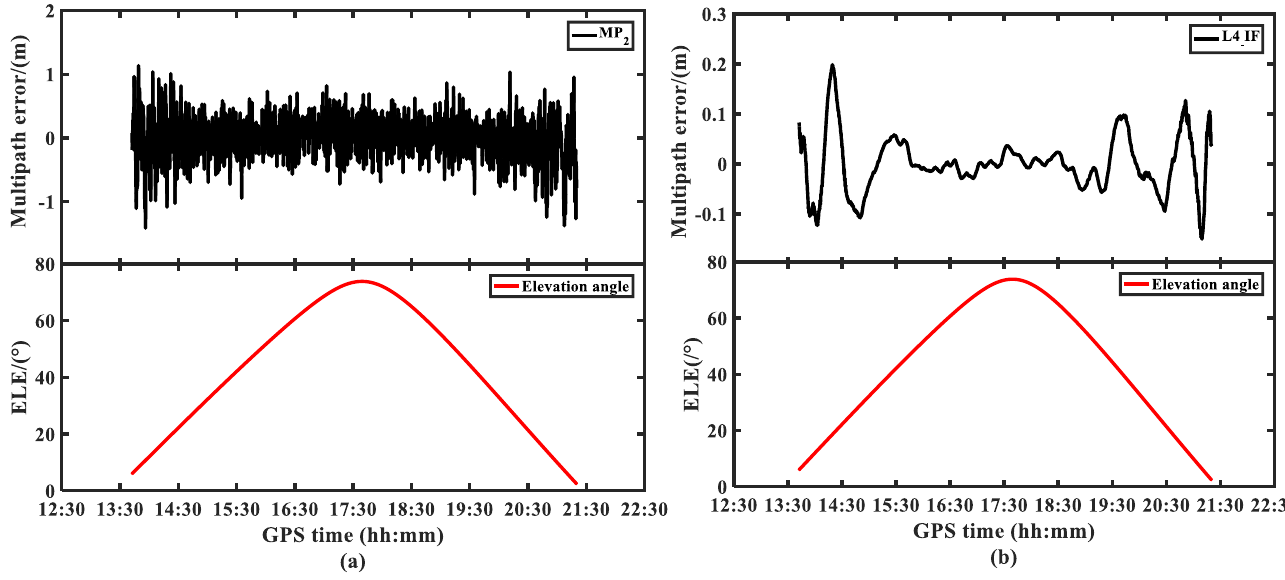
Figure 7. The multipath error varies with satellite elevation angle: ( a ) dual-frequency pseudorange multipath error; ( b ) dual-frequency carrier phase linear combination of multipath errors.